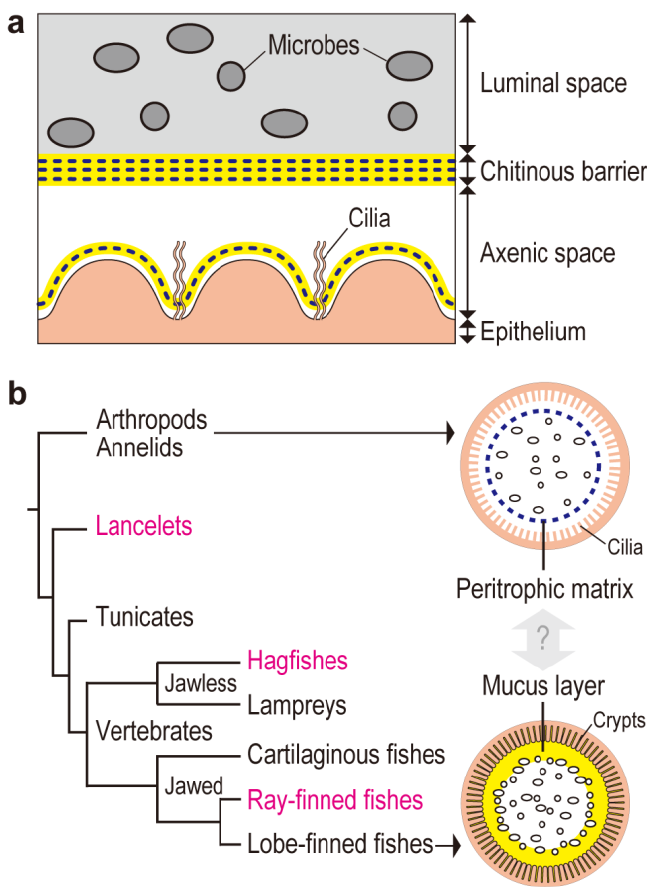
FIGURE 1: Chitin-based barrier immunity. (a) A model for the tunicate Ciona intestinalis Type A. The gut space is radial- ly compartmentalized into luminal space, to which filter-fed microbes are confined, and peripheral axenic space over the ciliated epithelium, defined by multi-layered chitinous mem- branes. Chitinous membranes are framed with meshed chitin nanofibers (blue dotted line) embedded in proteinaceous matrix containing gel-forming mucin (yellow). Delamination of a new membrane from the epithelium renews axenic con- ditions. (b) Evolutionary implications. The tree diagram at left depicts phylogenetic relationships of chordates. Two arrows extending from invertebrate outgroups and lobe- finned fishes, which include mammals, point to schematic drawings of intestinal barrier immunity representative of each group. The Ciona chitinous barrier ( a ) provides molecu- lar evidence for a possible link between the invertebrate peritrophic matrix (blue dotted line) and the mammalian mucus layer (yellow). To test this idea, animal groups that occupy intervening phylogenetic positions (typed in magen- ta) are critical. Adapted from Nakashima et al. Nat Commun 9: